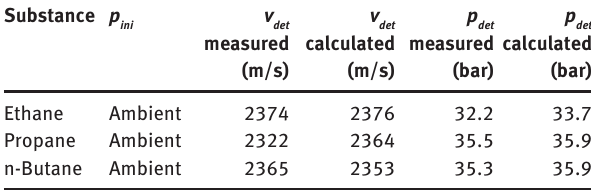
Table 2 Comparison of measured and calculated detonation velocities and pressures for stoichiometric (equivalence ratio = 1) hydrocarbon/oxygen mixtures at ambient conditions ( T = 21 ° C, p = ambient).